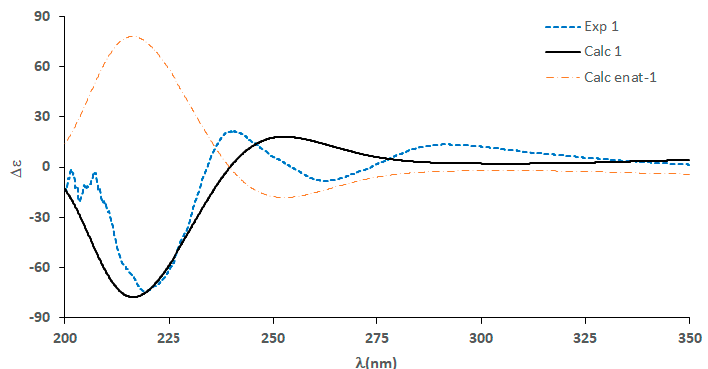
Figure 3. Experimental and calculated ECD spectra of 1 .